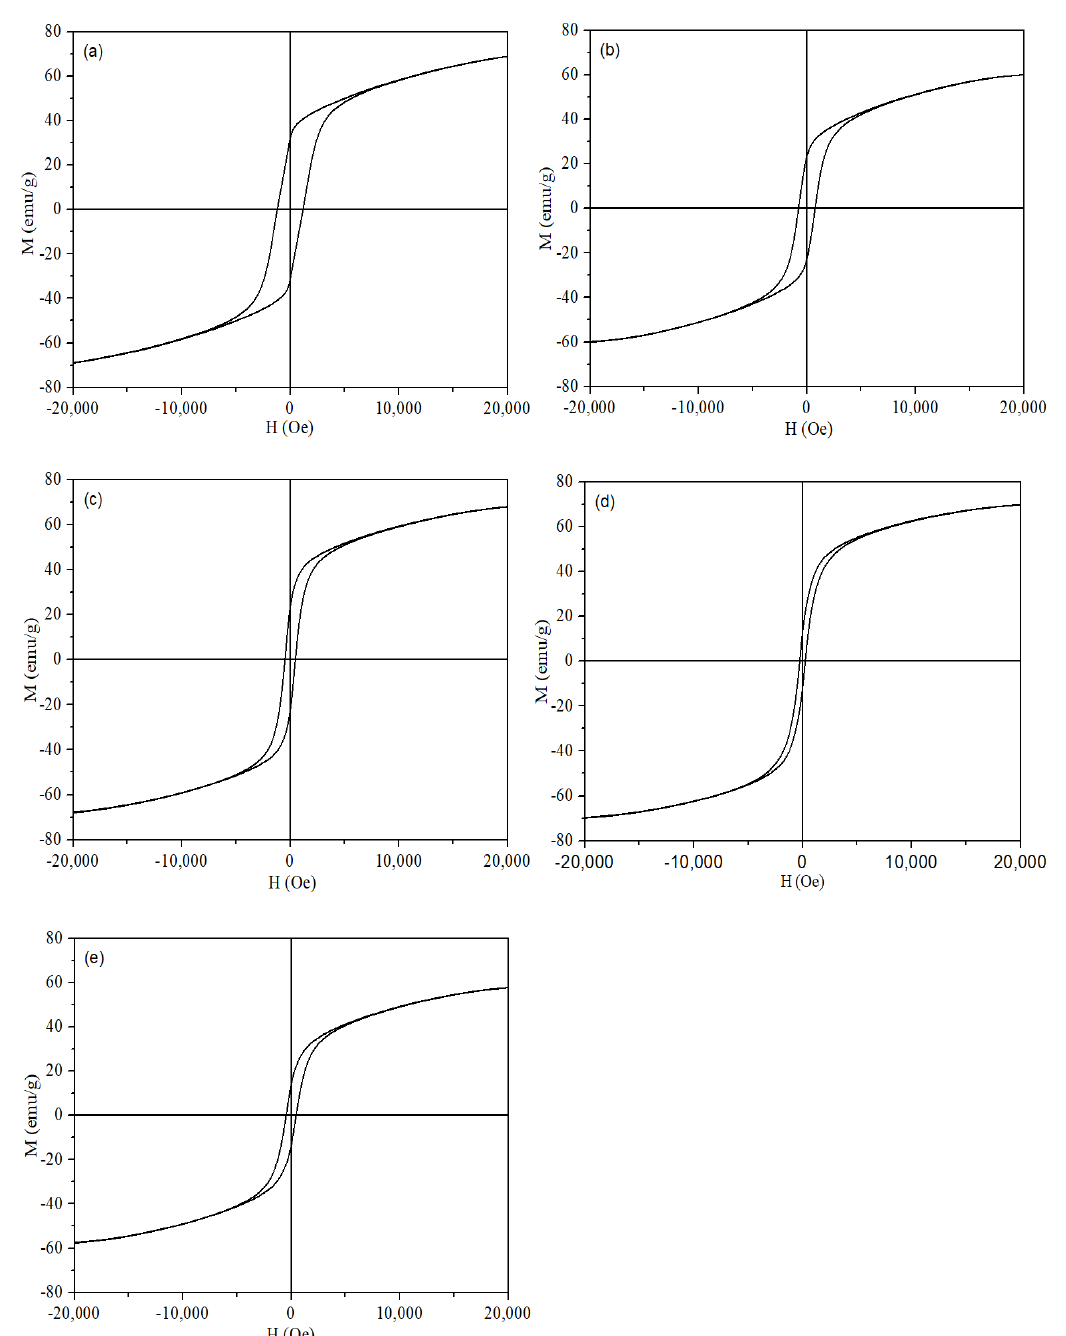
Figure 5. RT magnetic hysteresis loops of specimens with different precursors: ( a ) Co-, ( b ) Ni-, ( c ) Cu-, ( d ) Zn- and ( e )